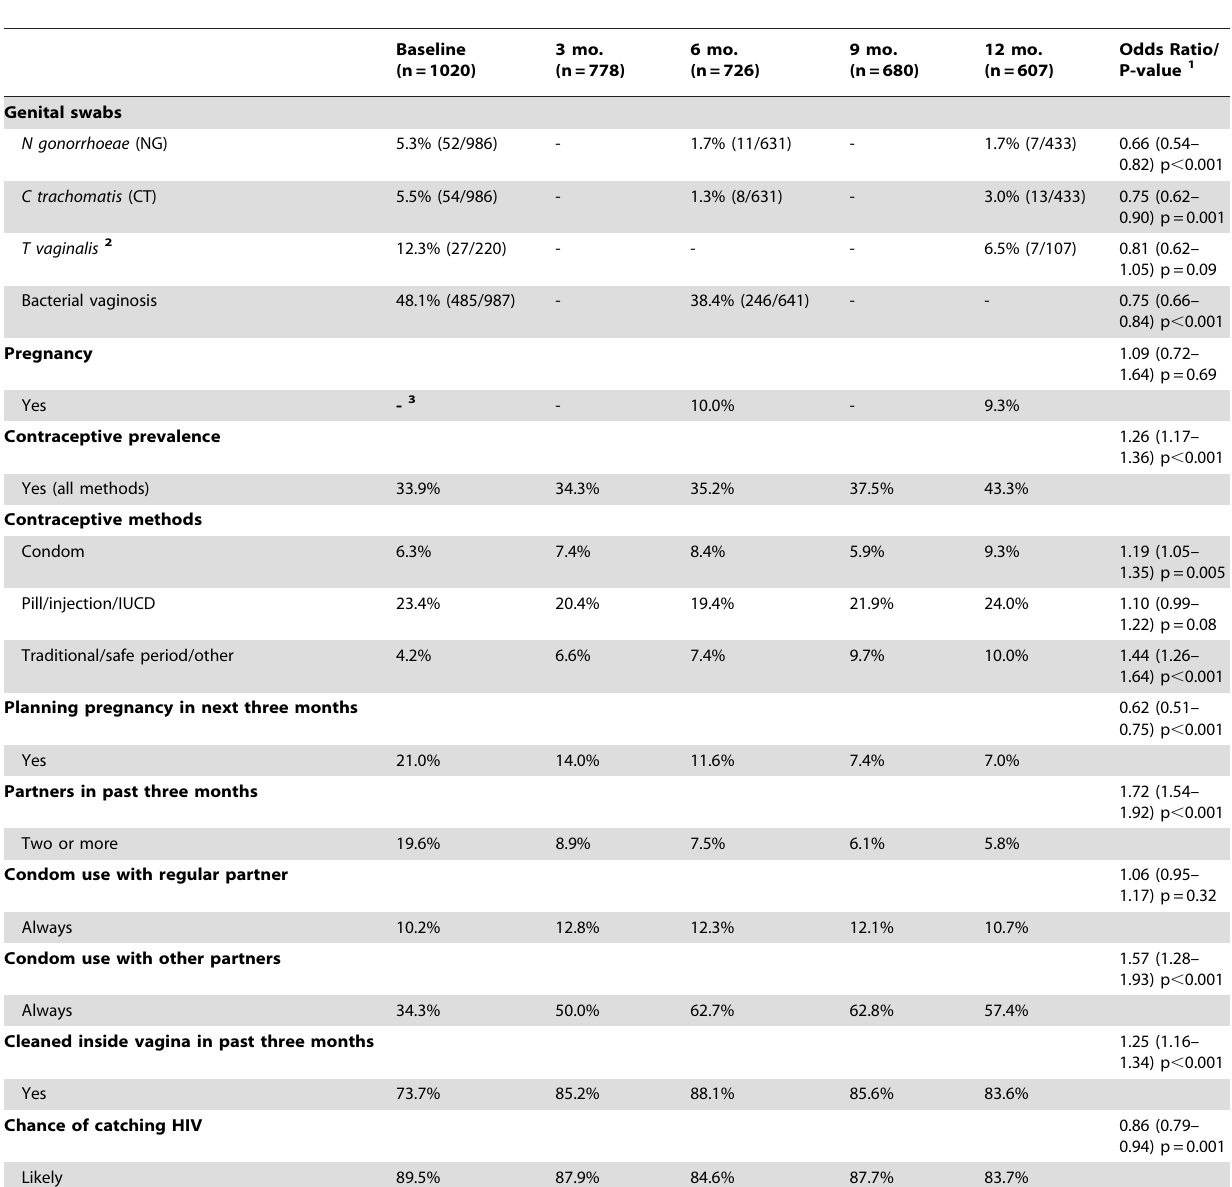
Table 4. Prevalence of STIs, pregnancy, contraception and reported sexual behaviour at baseline and scheduled follow-up visits among 1020 potential trial